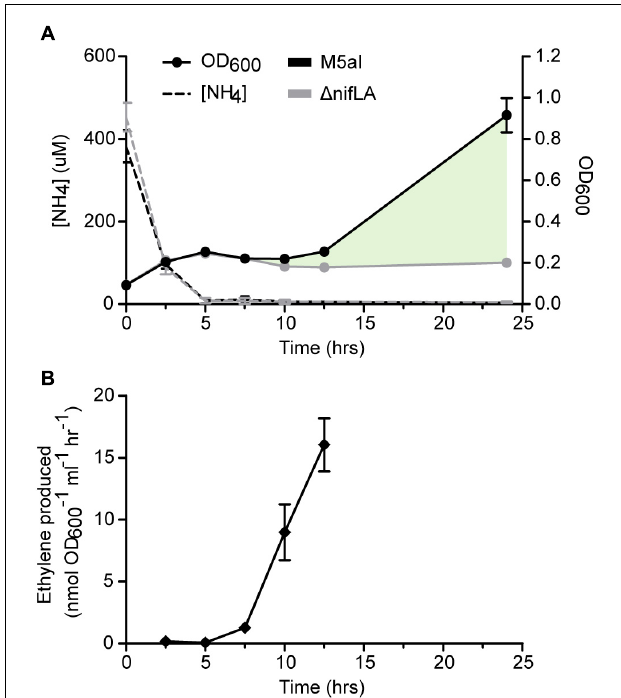
FIGURE 1 | Physiological parameters of NH 4 + run-out and diazotrophy. Ko M5a1 wild-type (black) and (cid:49) nifLA (gray) strains were cultured for 24 h in NFDM medium supplemented with 0.5 mM NH 4 Cl under micro-aerobic conditions. (A) Cell density (OD 600 , filled circles) and supernatant NH 4 + concentration (dashed lines) were measured at 2.5 h intervals and again after 24 h. Cell growth attributable to NifLA expression and diazotrophy is represented by shaded fill (pale green). (B) Culture headspace was sampled at 2.5-h intervals (between 2.5 and 12.5 h) for detection of nitrogenase activity via the acetylene reduction assay. Acetylene was injected into the head space at t = 0 h. Activity values correspond to ethylene evolved per hour and per unit cell density at 25 ◦ C. Error bars represent SEM of three biological replicates. Acetylene reduction was not assayed at 24 h.